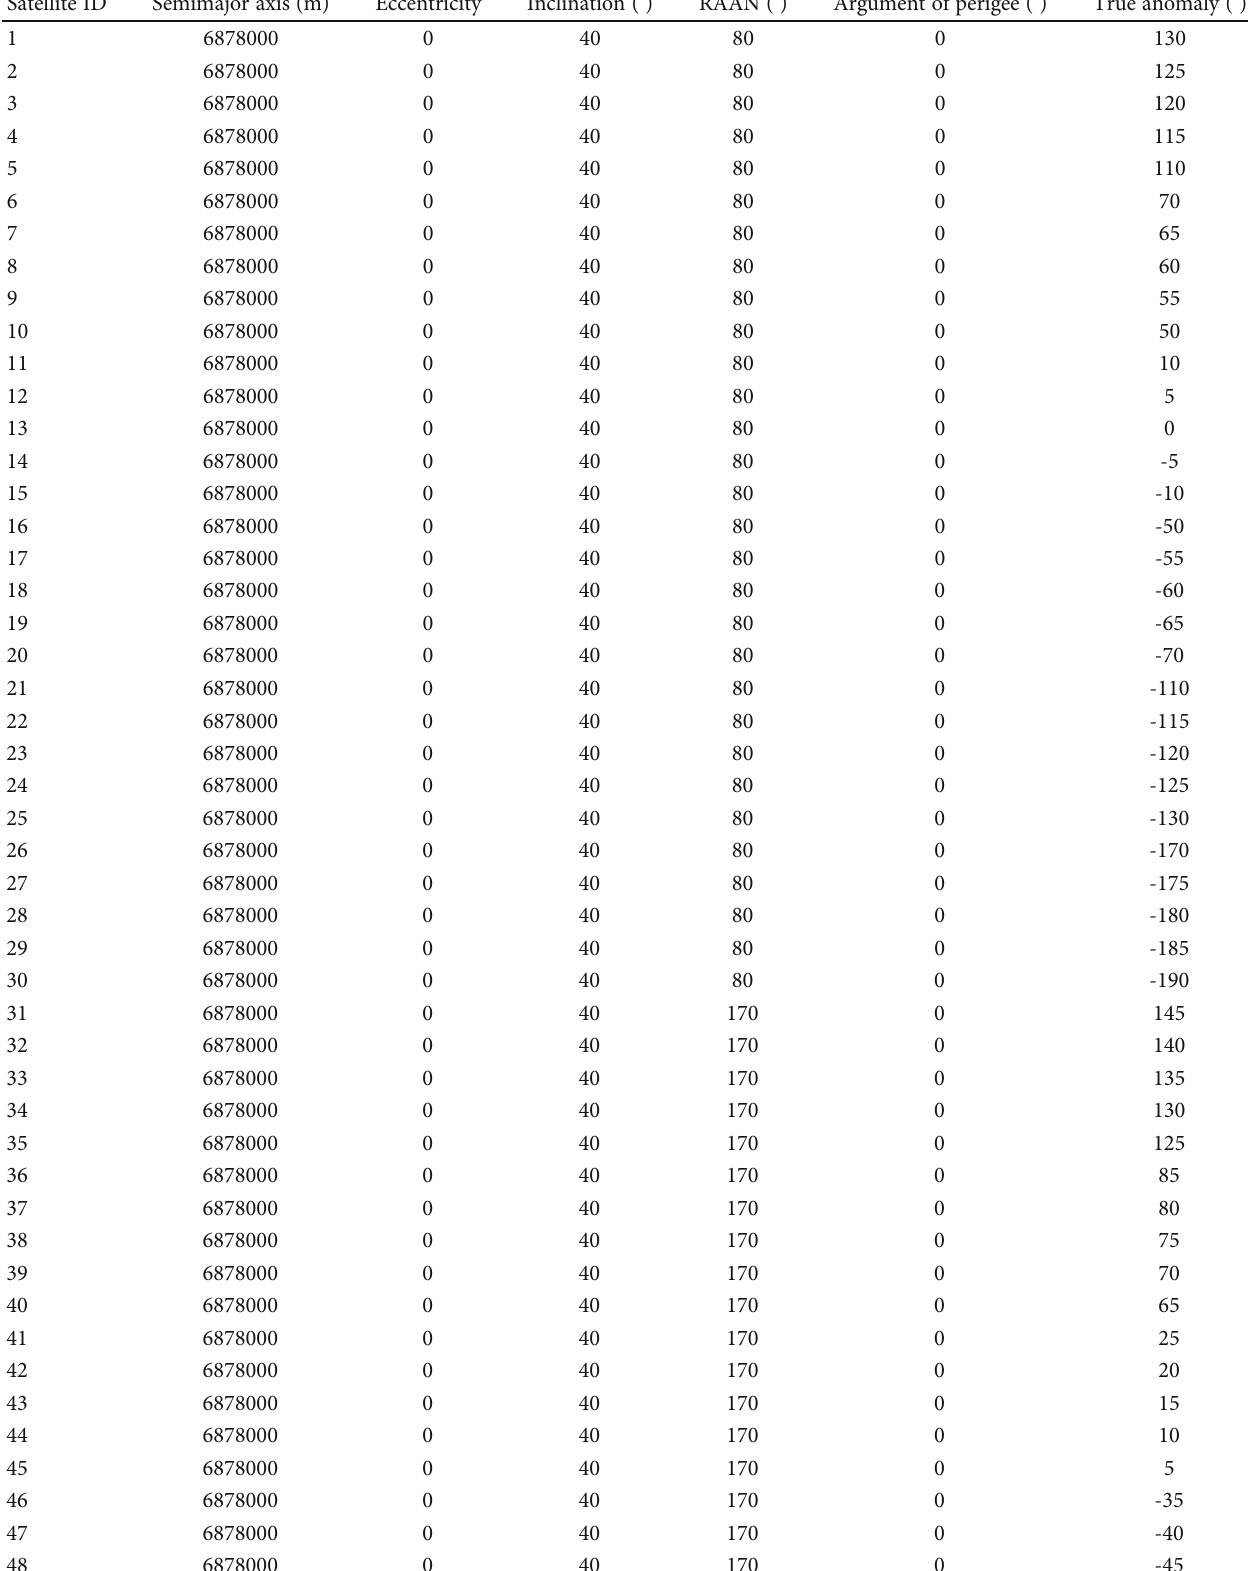
Table 3: The orbit parameters of all